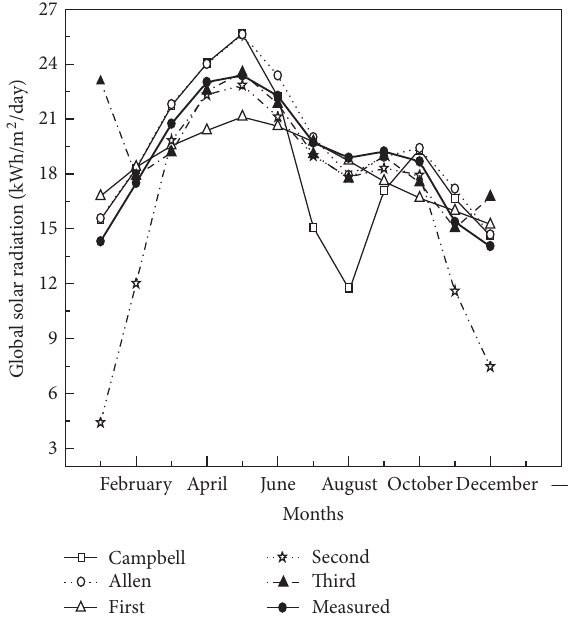
F 1: Measured and estimated global solar radiation